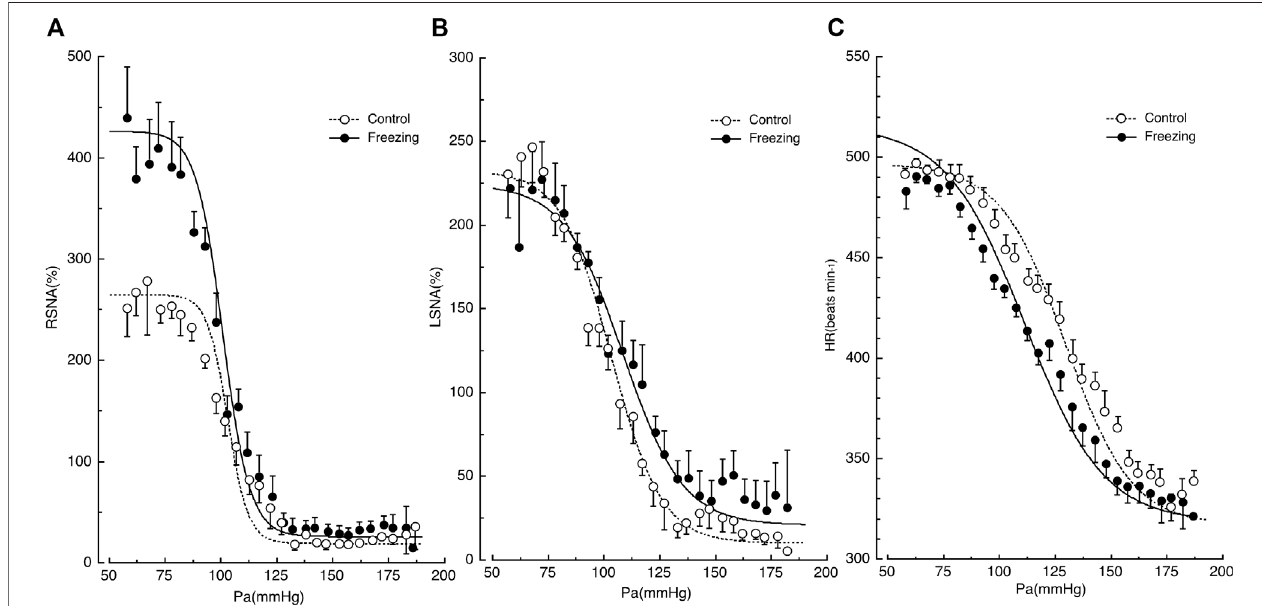
FIGURE 1 | Shifts in the barore fl ex curves for renal sympathetic nerve activity (RSNA) in panel (A) , lumbar sympathetic nerve activity (LSNA) in panel (B) , and heart rate (HR) in panel (C) during the control and freezing periods. AP, arterial pressure. Symbols and bars indicate the mean and standard error of mean, respectively. The image was obtained with permission from the study by Kondo et al.